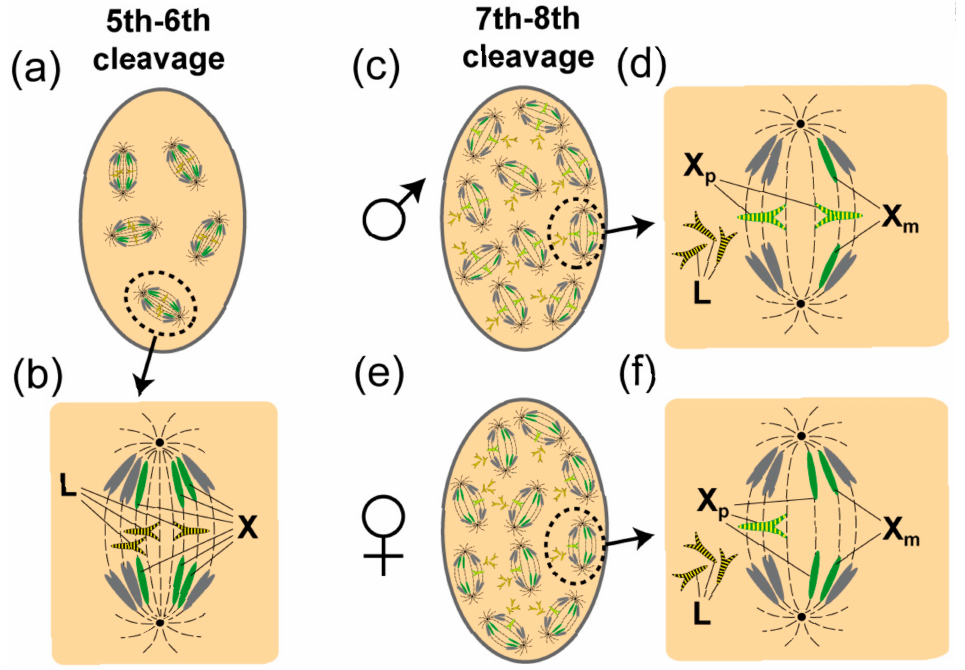
Figure 1. Elimination of L and paternal X chromosomes (Xp) in the embryonic soma. ( a ) Several mitoses are depicted in an embryo at the 5–6th embryonic cleavage where the L chromosomes are in the process of being eliminated. ( b ) One is magnified and shows that that the L chromosomes are left behind at the equatorial plate and fail to separate. The arms of the L chromosomes retain high levels of phosphorylation of histone H3 serine 10 (H3S10P) (shown as yellow stripes). ( c ) In males at the 7–8th cleavage two Xps are eliminated. ( d ) As with the eliminated L chromosomes, the arms of the eliminated Xps fail to separate and likewise retain high levels of H3S10P (shown as yellow stripes). The Xps remain at the equatorial plate and are eliminated giving a somatic male (XO) chromosome constitution. In ( d ) phosphorylated L chromosomes that have already been eliminated are shown. ( e ) In females, a single Xp is eliminated at the 7th–8th cleavage division. ( f ) The single Xp remains at the equatorial plate and retains high levels of H3S10P (shown as yellow stripes). Note that by contrast to the eliminated chromosomes the chromosomes that move away to the poles have lost H3S10P. Eliminations normally take place at the periphery of the multinucleate cell but because the diagram is in 2 dimensions mitoses are seen to fill the cell. The L chromosomes are black, the autosomes are grey and the Xps are green. Phosphorylation is depicted as yellow